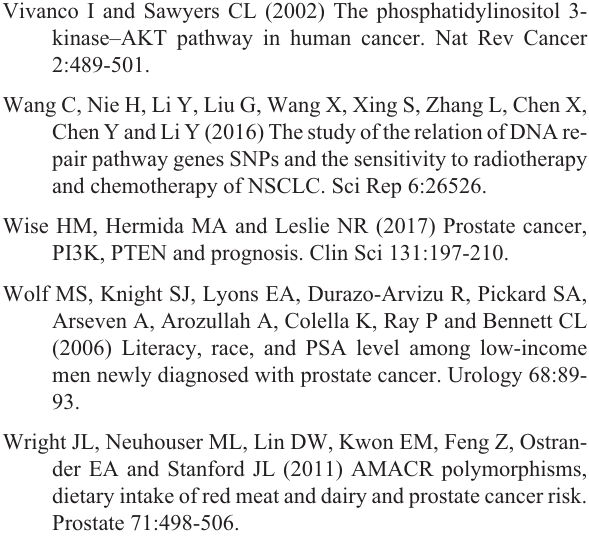
Table S1 – Univariate and multivariate regression analysis of association of genotypes of PTEN , AKT , PI3K , AR , and AMACR genes with prostate cancer risk. Table S2 – Association between genotypes of PTEN , AKT , PI3K , AR , and AMACR genes and clinicopathological fea- tures in prostate cancer